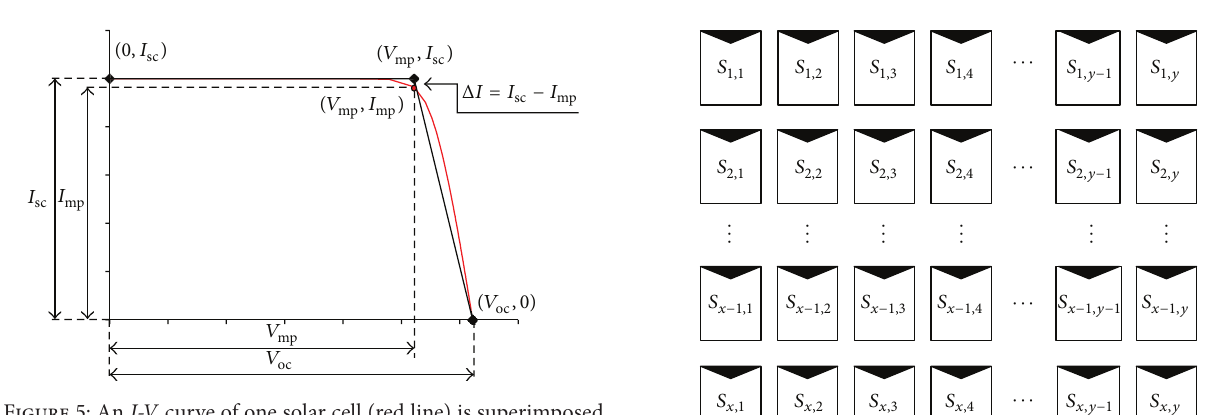
Figure 5: An I-V curve of one solar cell (red line) is superimposed with a new TPM prediction model (black line), consisting three critical points, namely, (0, 𝐼 cells that are present at the corresponding row. The number